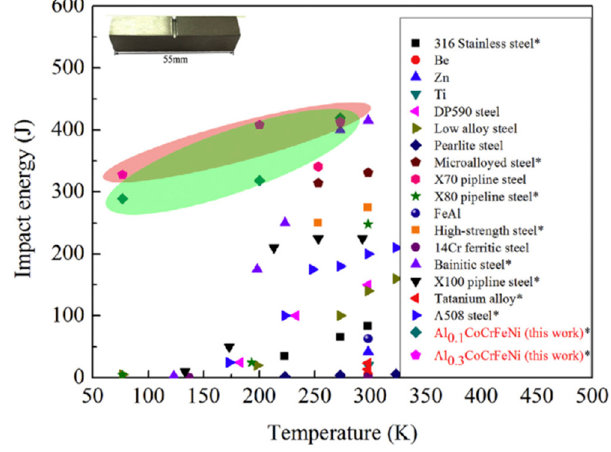
Figure 7. Summary of the Charpy impact energy of materials at the different temperatures. The dimension of alloy samples with * is 10 × 10 × 55 mm 3 . Reprinted with permission from Ref. [28]. Copyright 2016, Elsevier.